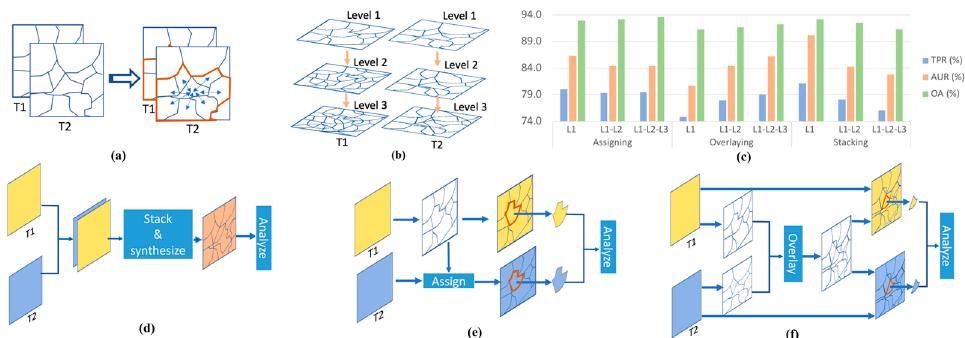
Figure 22. Representative examples of object-based methods for correlation analysis. ( a ) Consider the relationship between adjacent objects on the same layer. ( b ) Consider the relationship between the generated multi-level, multi-scale objects. ( c ) Comparison histogram of methods for the multi-level and multi-scale object methods. ( d ) Assign the result of the multi-scale objects generated by one image to another image. ( e ) Overlap the results of multi-scale objects generated by all multi-temporal images. ( f ) Stack the multi-temporal images and then carry out the generation of multi-scale